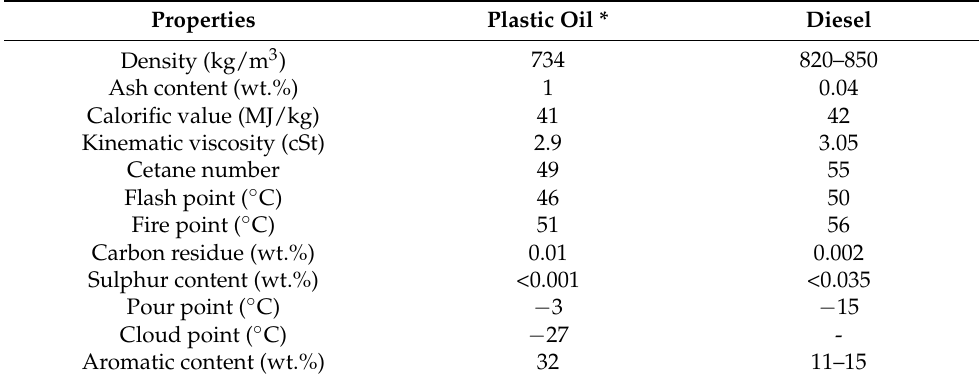
Table 7. A comparison between plastic oil and diesel physicochemical properties